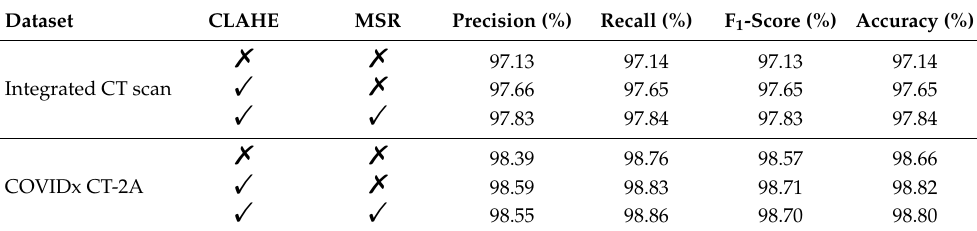
Table 2. Comparison of preprocessing